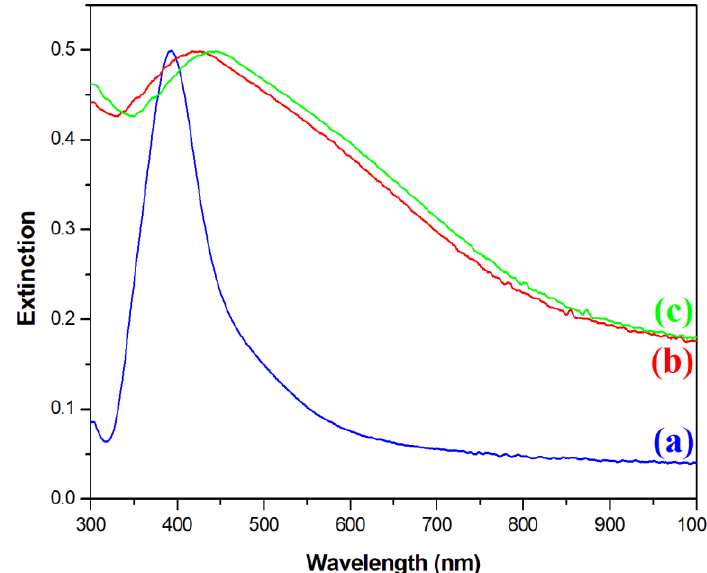
Figure 4. UV – vis extinction spectra of the sols of: ( a ) the Ag nanoparticles, ( b ) the Fe 3 O 4 @Ag nanocomposite before being covered with silica, and ( c ) the Fe 3 O 4 @Ag nanocomposite after being covered with a silica layer. The measurements were carried out using a standard rectangular 3.5 mL cuvette with an optical path of 1 cm.